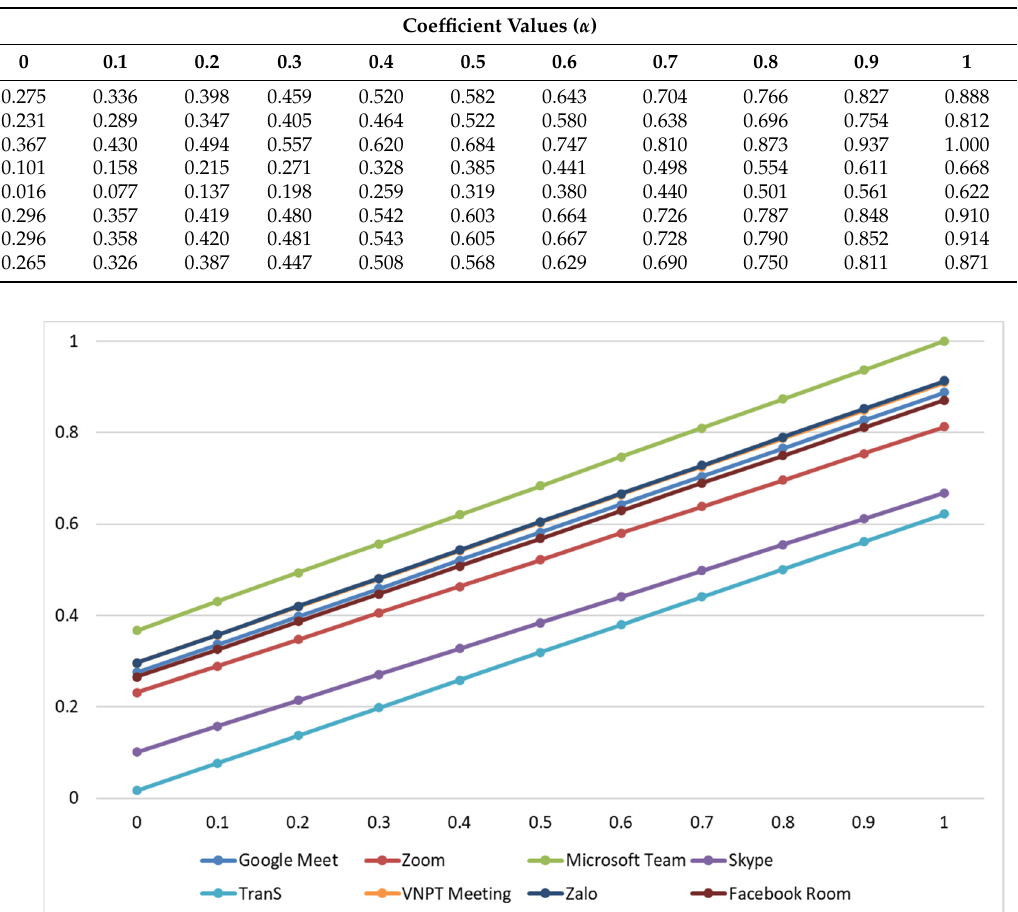
Figure 6. Sensitivity analysis of coefficient value of G-EDAS.